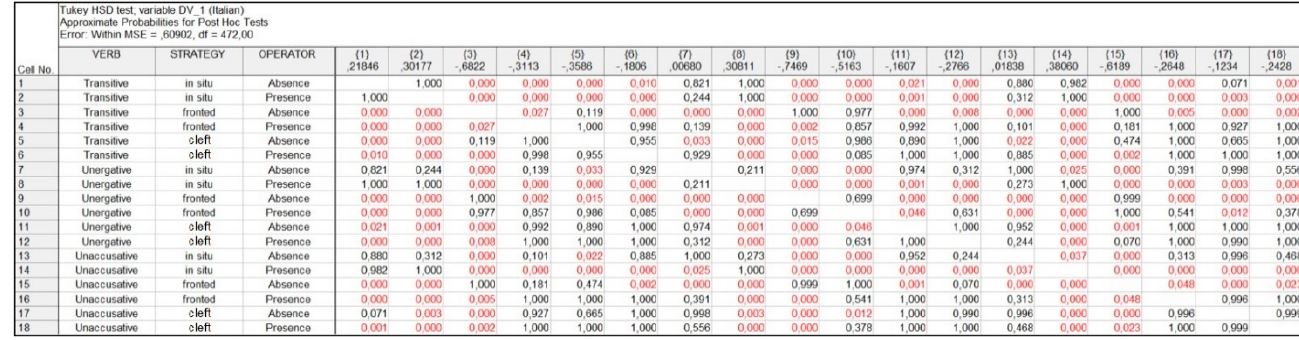
Figure 15. Three factors’ post hoc results (Italian) 19 .